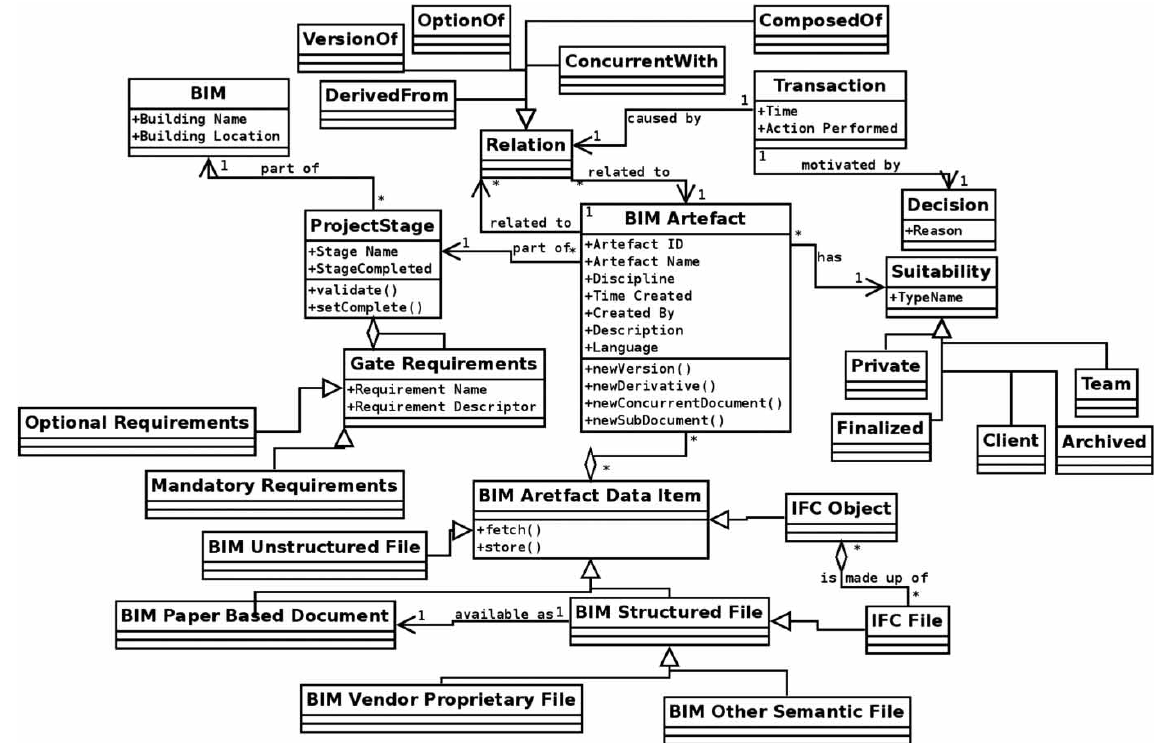
Fig. 5. BIM artefacts conceptualization